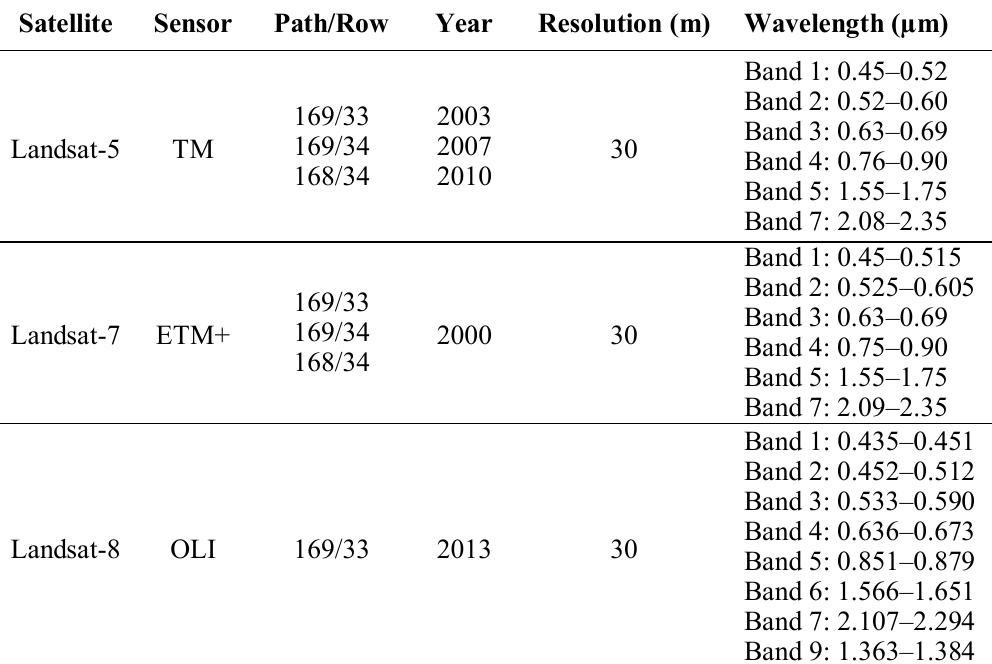
Table 1. Specifications of Landsat TM, ETM+ and OLI